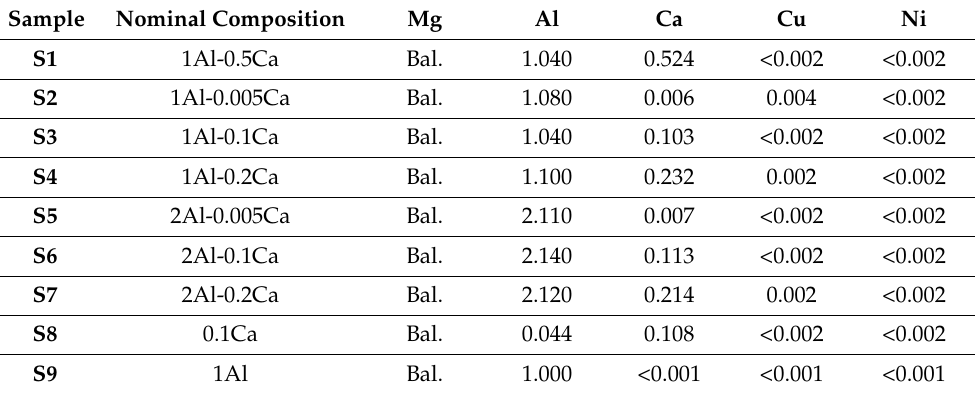
Table 1. Investigated compositions in wt.-% with their nominal and measured chemical compositions (with ICP-OES),